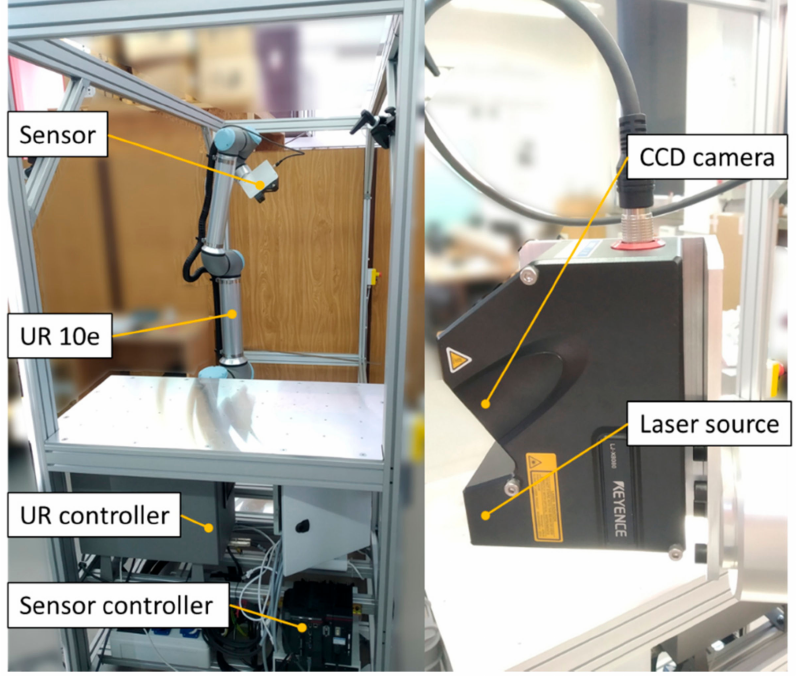
Figure 5. Experimental